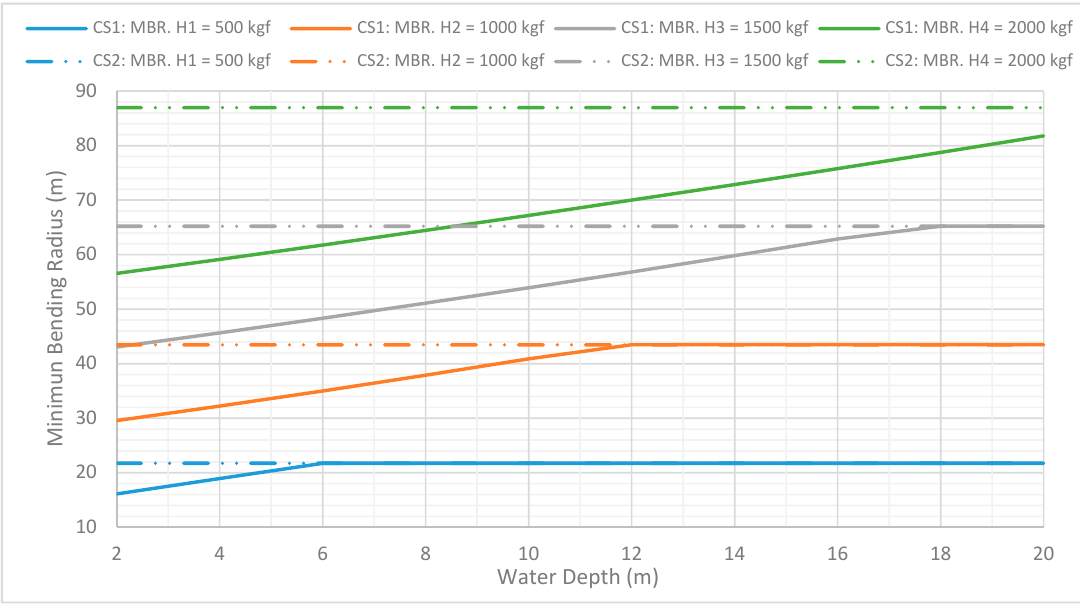
Figure 14. Minimum bending radius (MBR) assuming CS1 & CS2 using different bottom tensions (500 kgf–2000 kgf) and water depths (2 m–20 m).